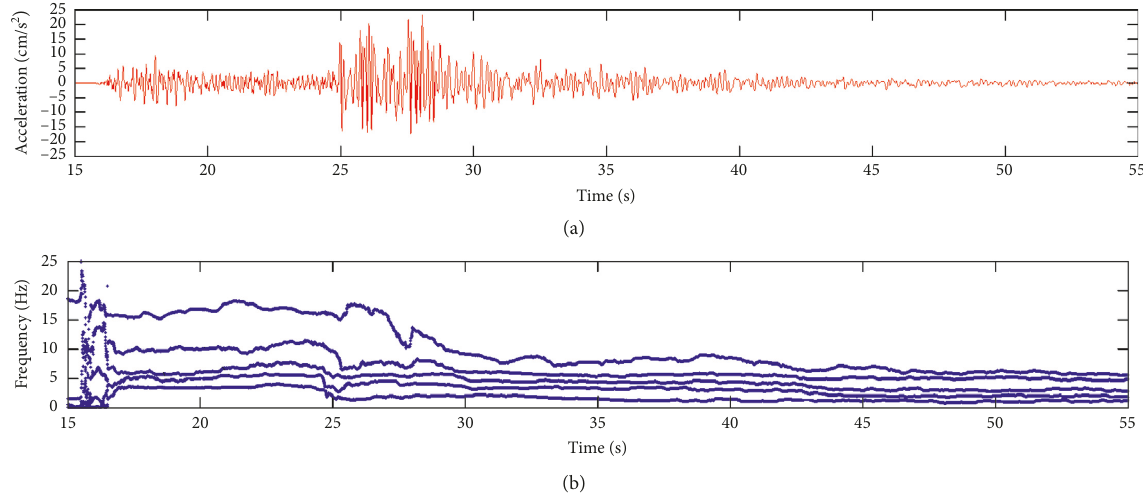
Figure 18: Time-varying modal identification results of the Pacoima dam using the Chino Hills earthquake data: (a) vibration response of channel 1; (b) identification results for frequencies.